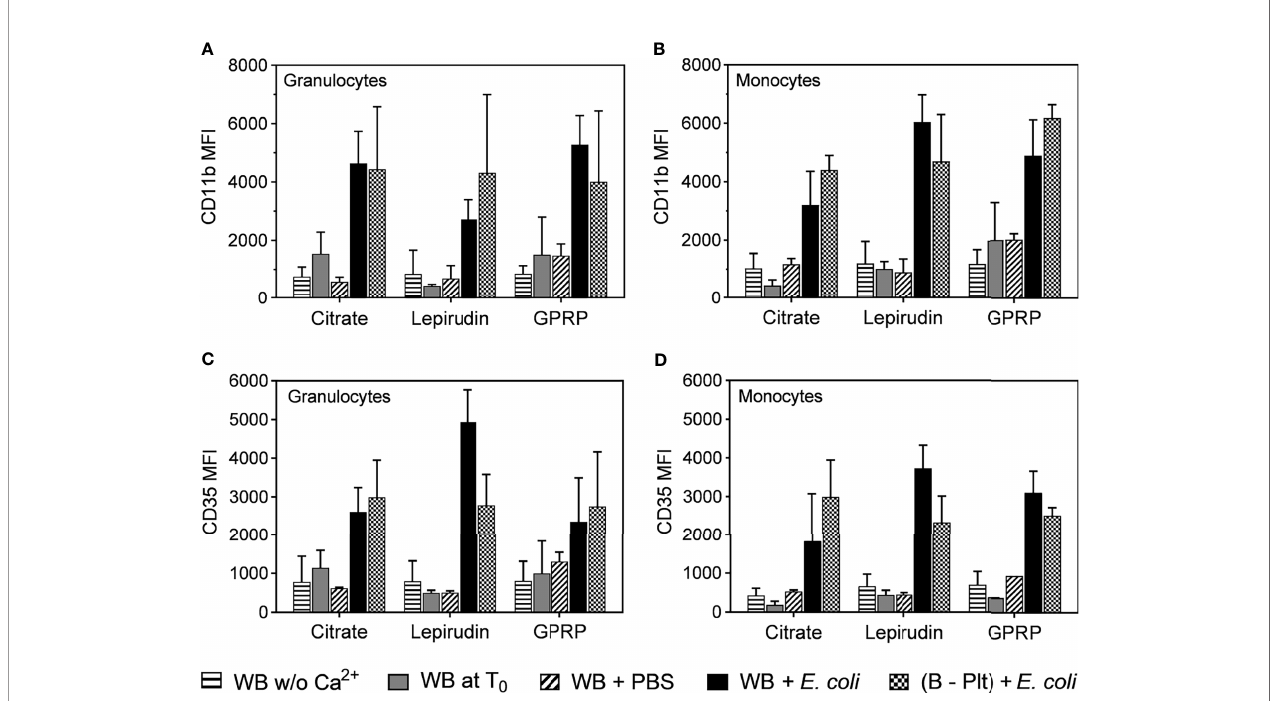
FIGURE 3 | Activation of granulocytes and monocytes during the platelet depletion process. The activation of granulocytes (A, C) and monocytes (B, D) were evaluated by the surface expression levels of CD11b (A, B) and CD35 (C, D) by fl ow cytometry. The activation of these cells was measured in whole blood immediately after collection without re-calci fi cation (indicated as “ WB w/o Ca 2+ ” ) or whole blood with Ca 2+ added at T0 (WB at T0). In addition, the activation of granulocytes and monocytes in Ca 2+ supplemented whole blood was incubated with PBS (WB + PBS) or E. coli (WB + E. coli ). After platelet removal, these cells were activated with E. coli ((B – Plt) + E. coli ). All incubations were carried out for 15 minutes after the addition of Ca 2+ . Data are presented as mean of median fl uorescence intensity (MFI) ± standard deviation (SD) (n =